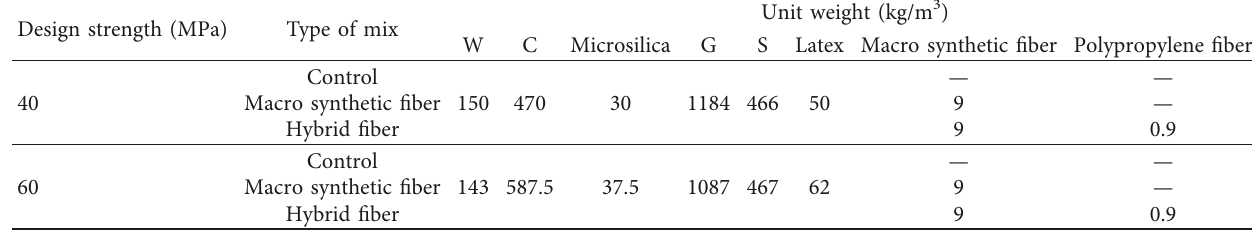
Table 8: Mixing ratio for optimal mix proportions determination.